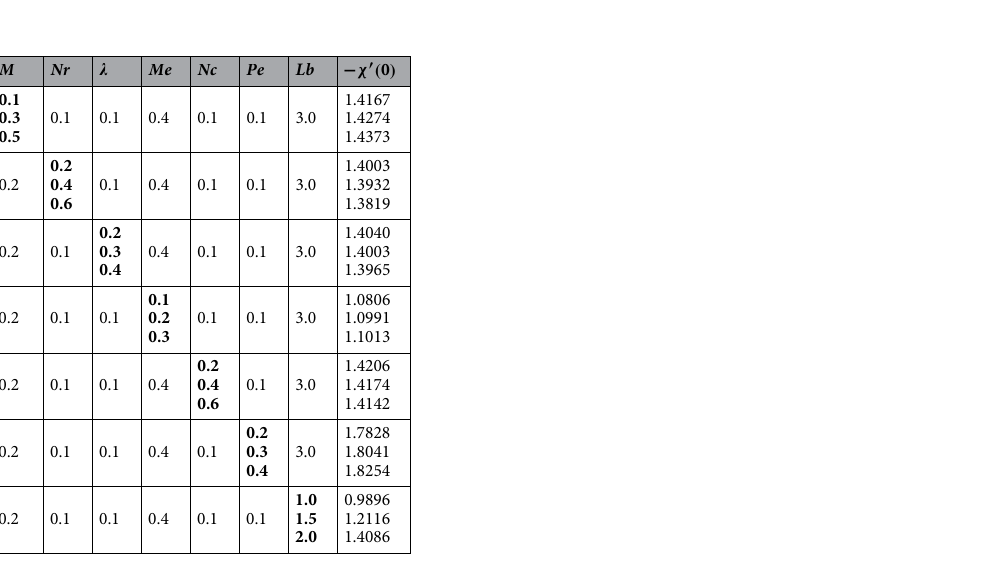
Table 5. Numerical estimations of local microorganisms density number Nr , (cid:31) , Me , Nc , Pe and Lb